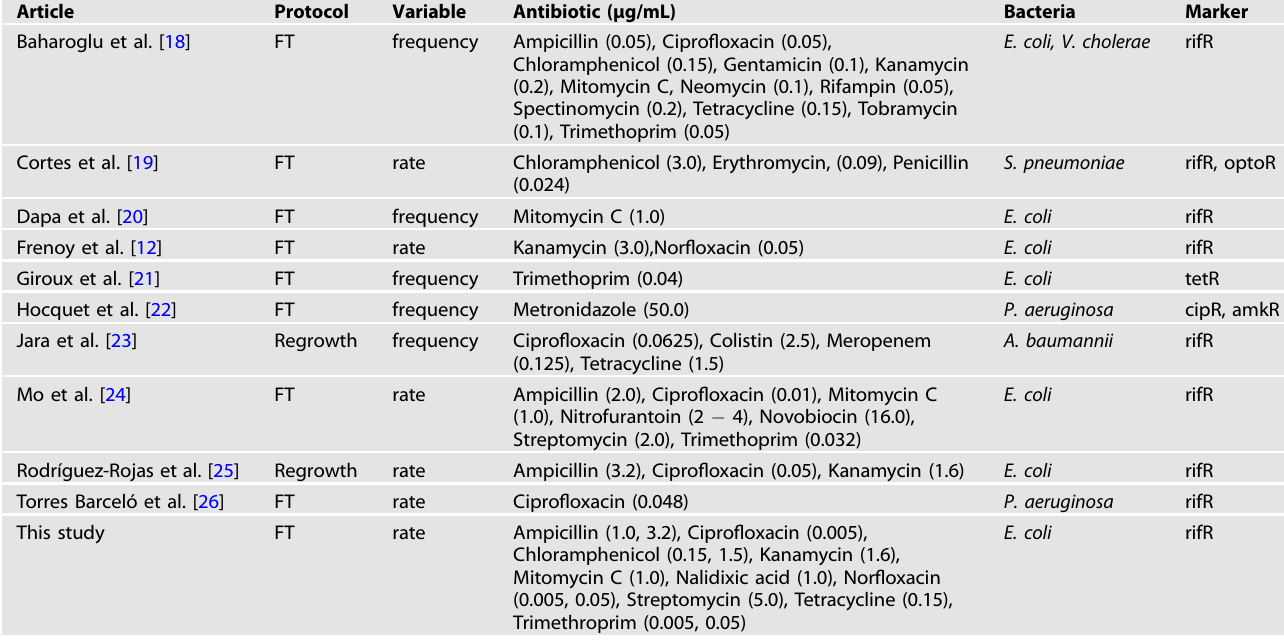
Table 1. Experimental data analyzed in this